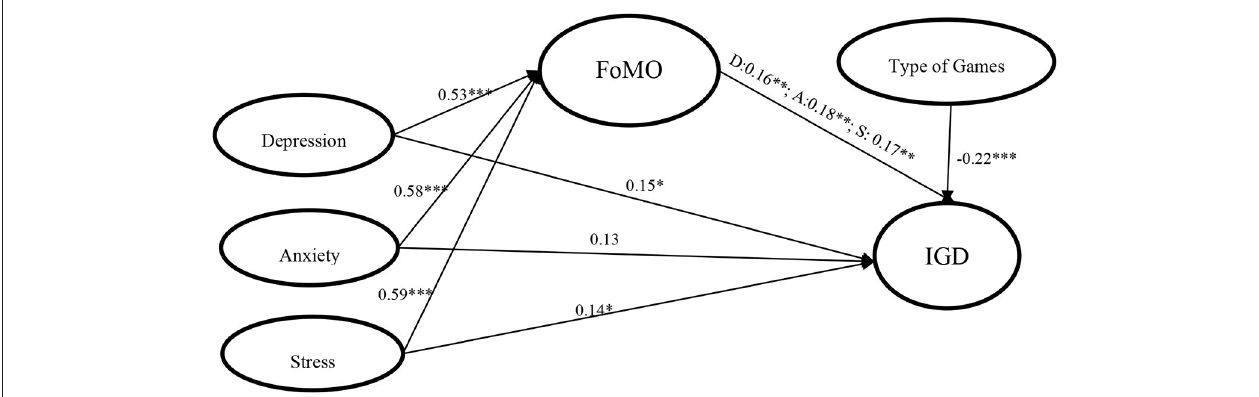
FIGURE 2 | The mediating role of FoMO in the various dimensions of negative emotion and internet gaming disorder. * p < 0.05, ** p < 0.01, *** p < 0.001; FoMO, fear of missing out; IGD, Internet Gaming Disorder.